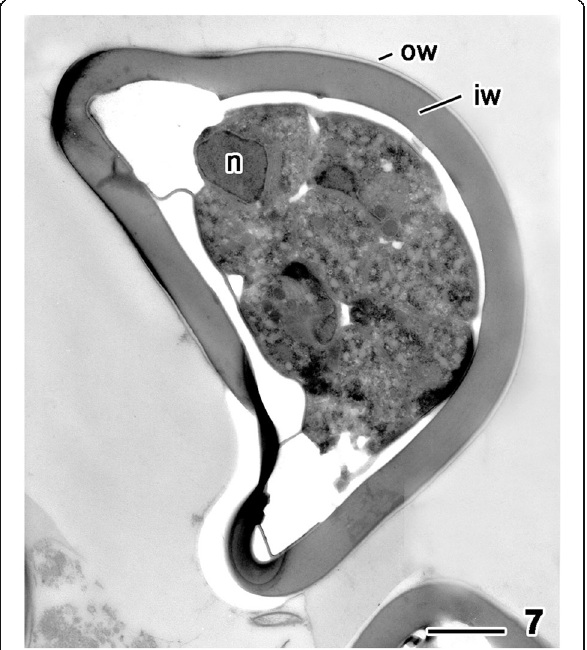
Fig. 7 Mature oocysts of Mattesia dispora , TEM. Cross-sections of oocysts including eight sporozoites. n nucleus, ow outer layer of oocyst wall, iw inner layer of oocyst wall. Bars, 1 μ